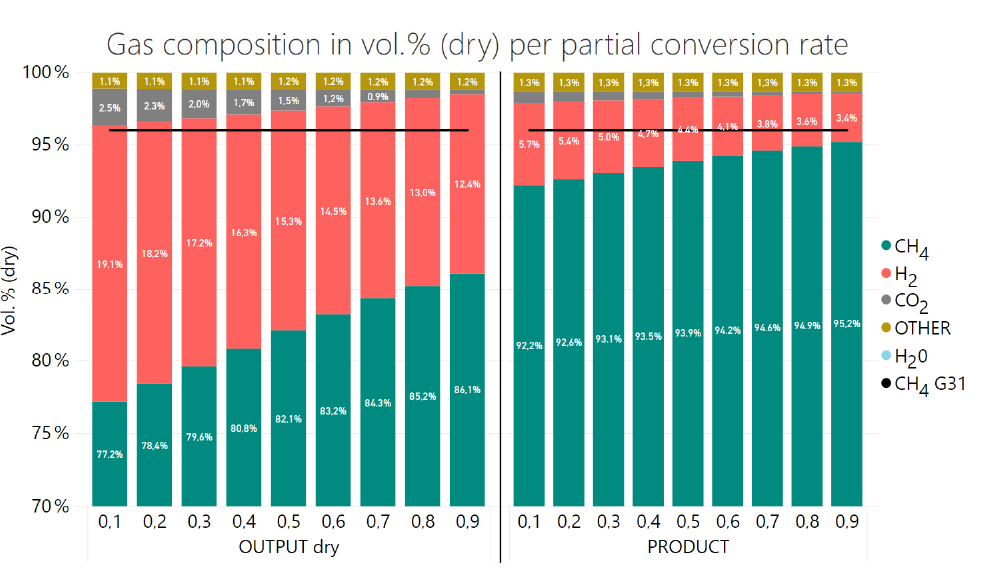
Figure 10. Gas composition of dry gas stream after water separation ( left ), and gas composition of product gas stream ( right ); all values in vol.-% (dry) for INPUT Case 2 (20% H 2 and 2.8% CO 2 ).